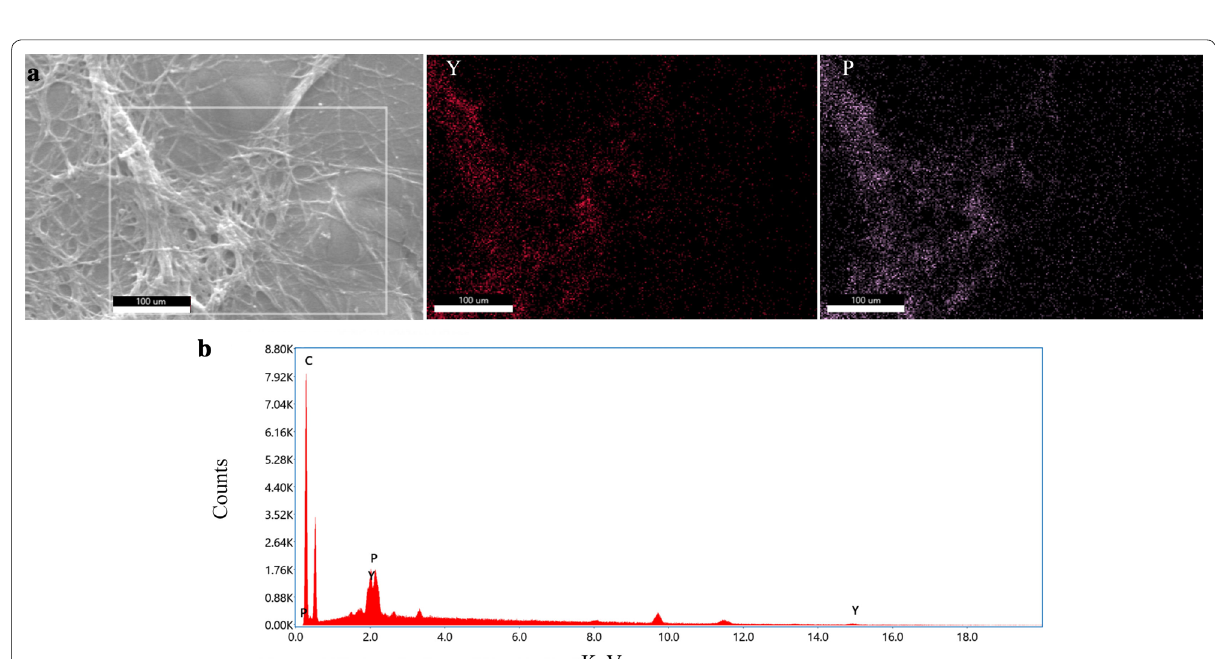
Fig. 5 SEM-EDX analyses of Y in the ZD28 strain. a Back scattered electron image of the ZD28 strain after cultivation in the presence of Y (left) and elemental maps of Y(red, middle) and P (pink, right). b Scans of the white rectangle box in a